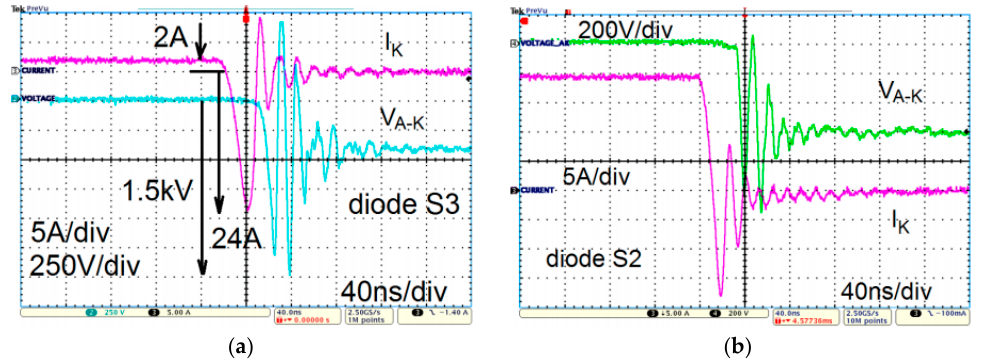
Figure 3. Comparison of reverse recovery transients using ( a ) Si fast recovery diode; and ( b ) SiC diode [29]. Reprint with permission [4062730593351]; Copyright 2011, IEEE.